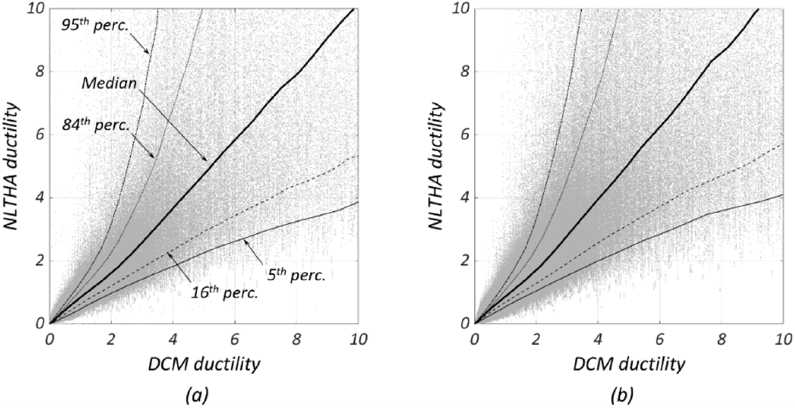
Figure 10. Comparison between ductility demands from the displacement coefficient method (DCM) by ASCE 41-17 and from NLTHA: ( a ) Suite 1-A, and ( b ) Suite 1-B.